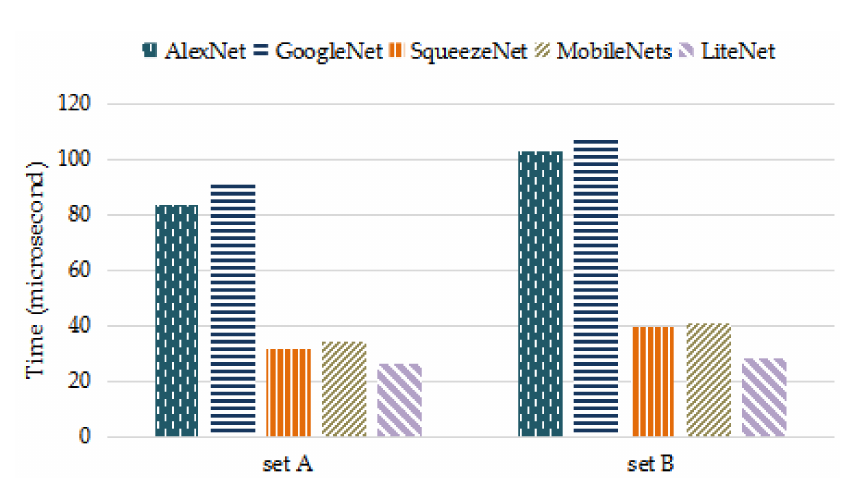
Figure 7. Training time of five models.